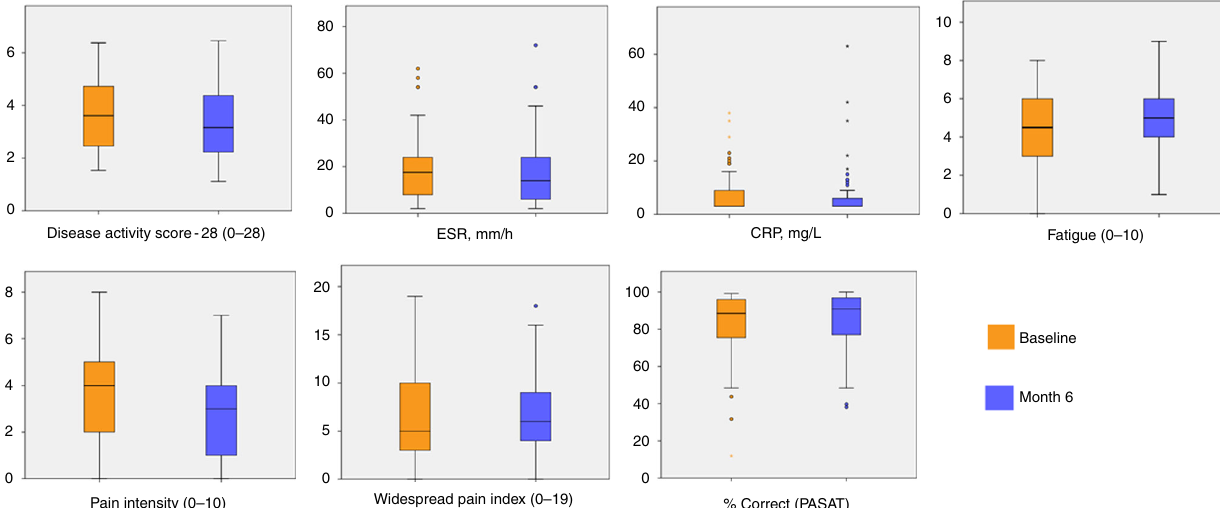
Fig. 1 Box plots of clinical characteristics and symptoms at baseline and 6 months for 54 rheumatoid arthritis patients. The center line represents the median value, the lower bound of the box represents the 25th percentile, the upper bound of the box the 75th percentile, and the whiskers represent minimum and maximum values, or 1.5 times the interquartile range in the presence of outliers, which are indicated by dots or